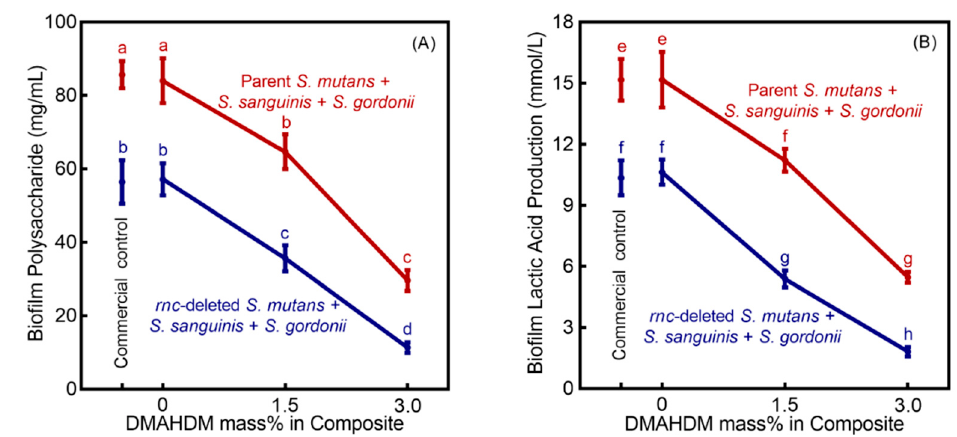
Figure 4. Inhibition effects of rnc knockout for S. mutans plus DMAHDM composite against cariogenic activities of Sm + Ss + Sg biofilms (mean ± SD; n = 6). ( A ) Polysaccharide production by Sm + Ss + Sg biofilms on composites. ( B ) Lactic acid secretion by Sm + Ss + Sg biofilms. Values with disparate letters (a, b, c, d, e, f, g, h) indicate data are significantly different ( p < 0.05).